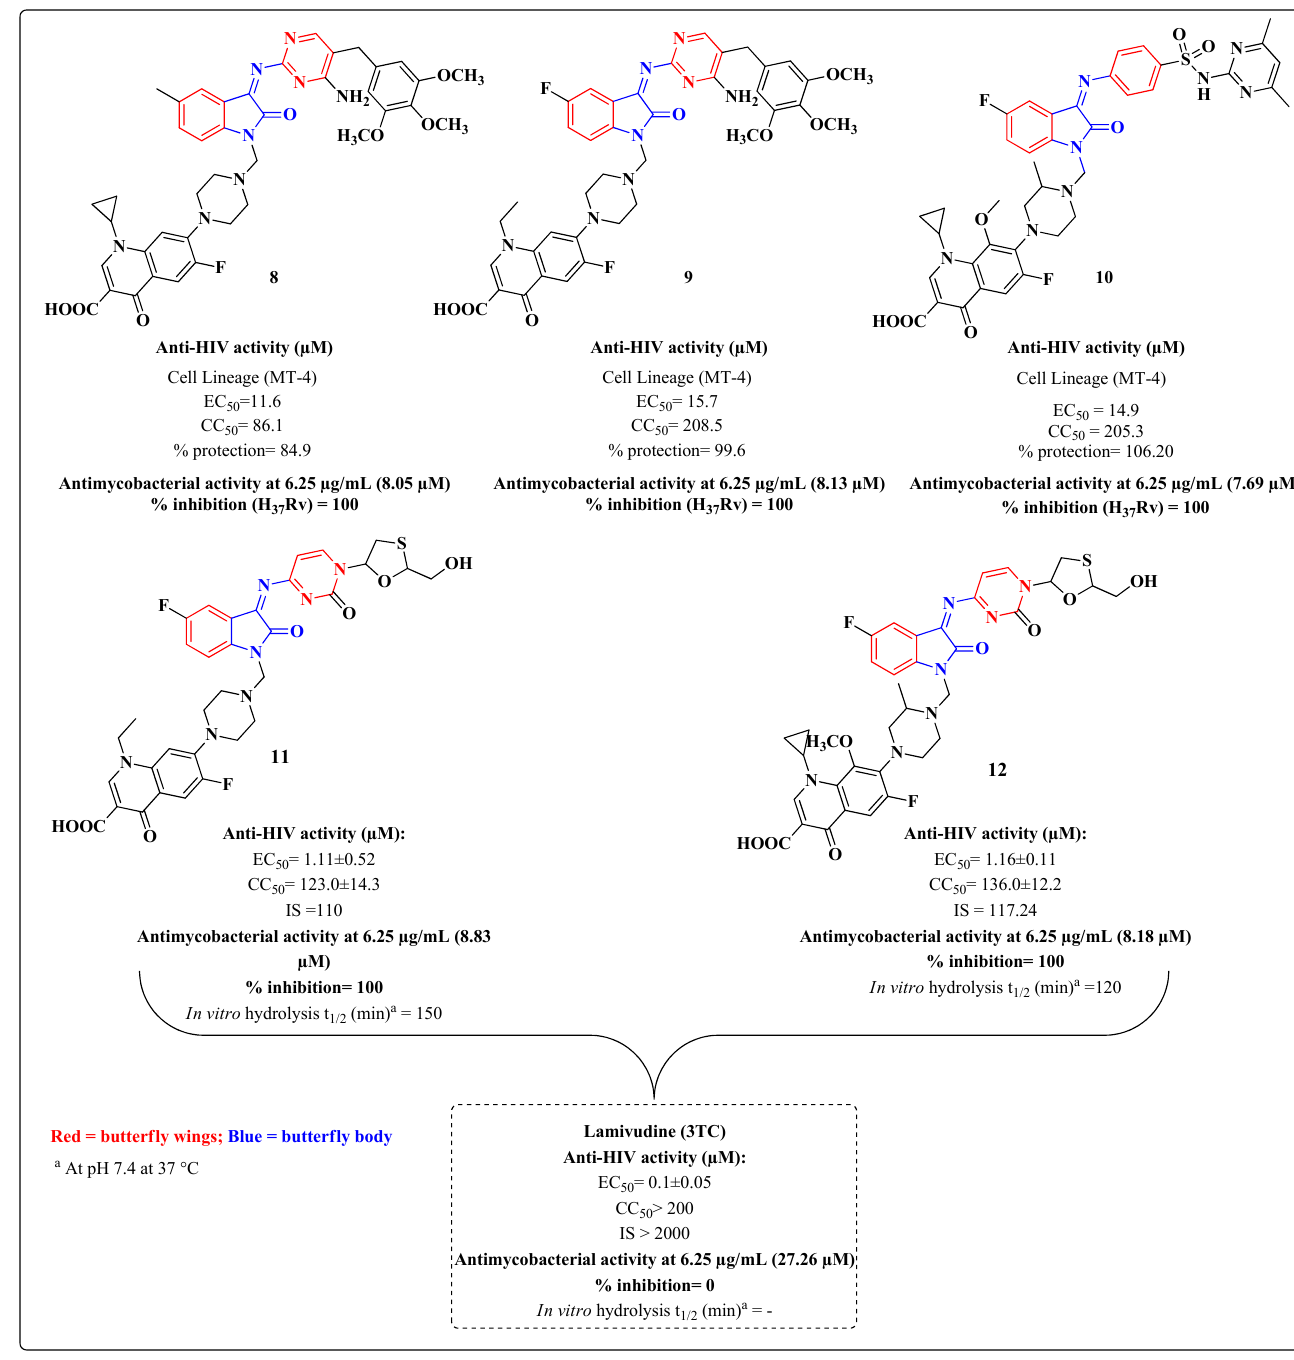
Figure 11. Basic skeleton of the novel isatin derivatives 8–12 and their anti-HIV and anti-MTB activities [83,84,86,89].